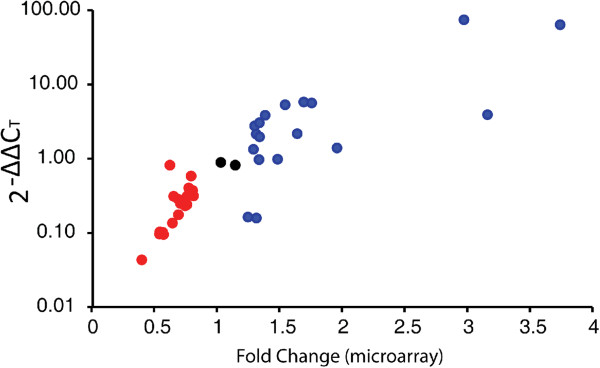
Significant positive correlation between fold change and threshold
cycle (CT) values (Spearman rank
correlation, Rs = 0.874,
N = 40, P <0.001).
Each data point represents 2-ΔΔCT of
quantitative real-time PCR performed on a subset of sequences to
verify the robustness of microarray results. Red and blue spots
represent down- and upregulated transcripts, respectively. The black
spots represent transcripts that were neutral to the treatment.